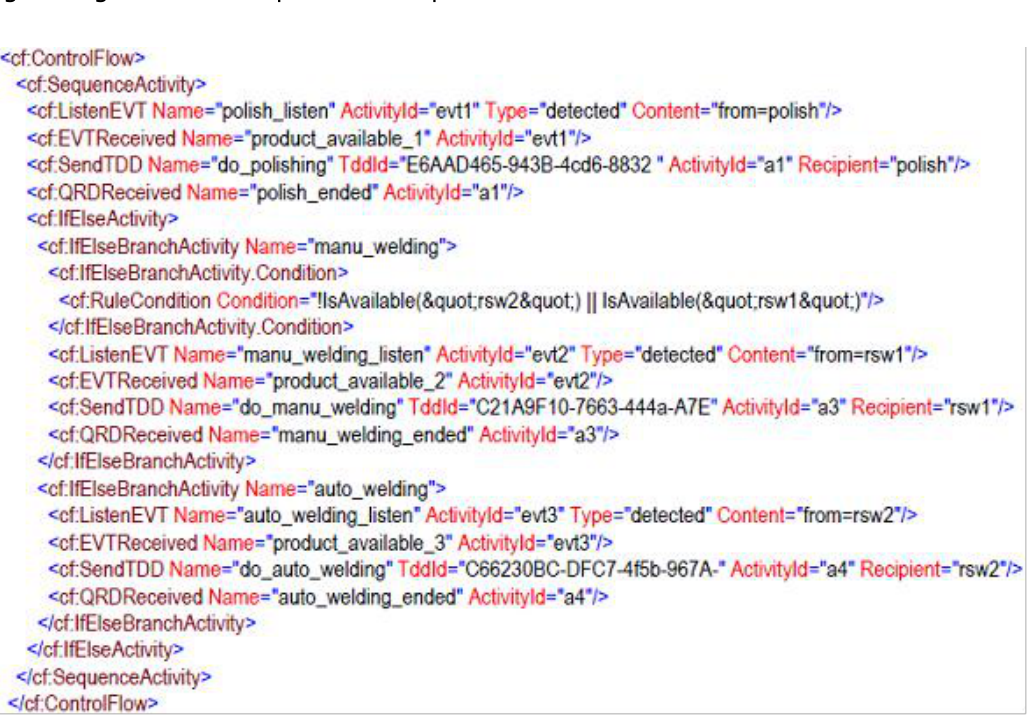
Figure 9. Sample control-flow of the Workflow Manager